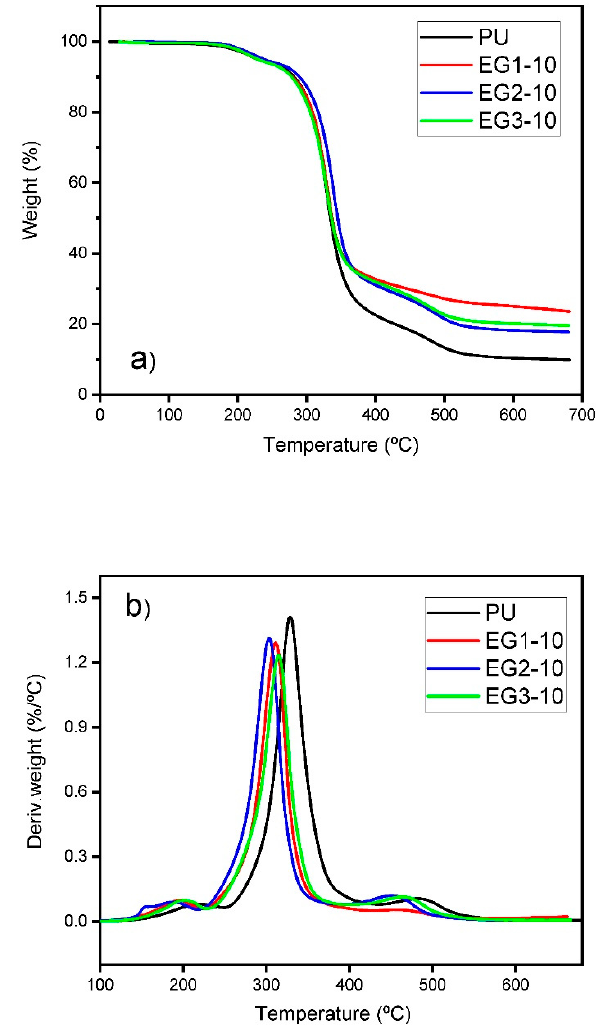
Figure 4. ( a ) TGA and ( b ) DTG curves for RPUF samples containing EG1, EG2, and EG3 at 10 wt % loading. Table 3. TGA data for EG/PU samples.